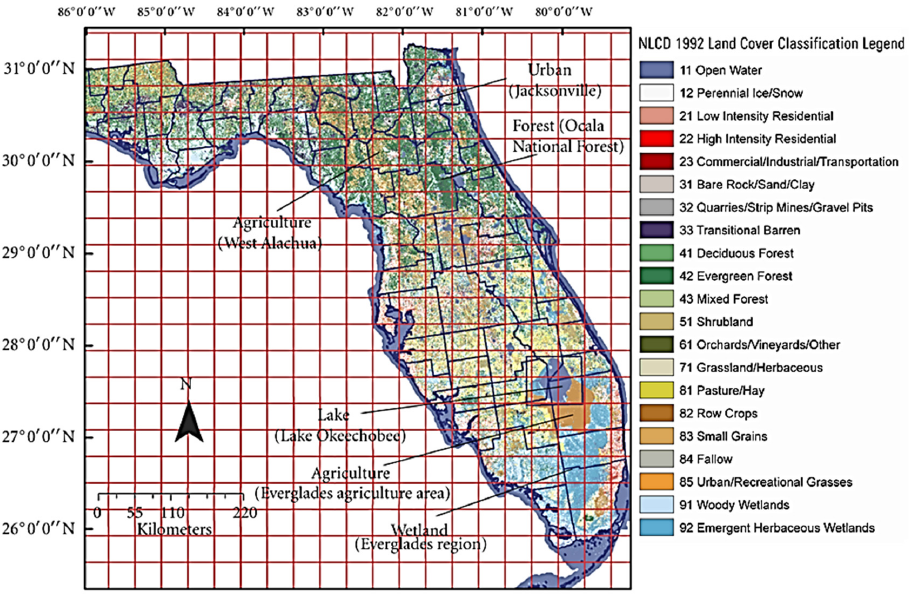
Figure 1. Six selected 32 × 32 km 2 regional study areas along with land-use/land cover from the 1992 National Land Cover Dataset. The red gridline is a 32 × 32 km 2 resolution grid from NARR Data reanalysis dataset (revised from [34]).